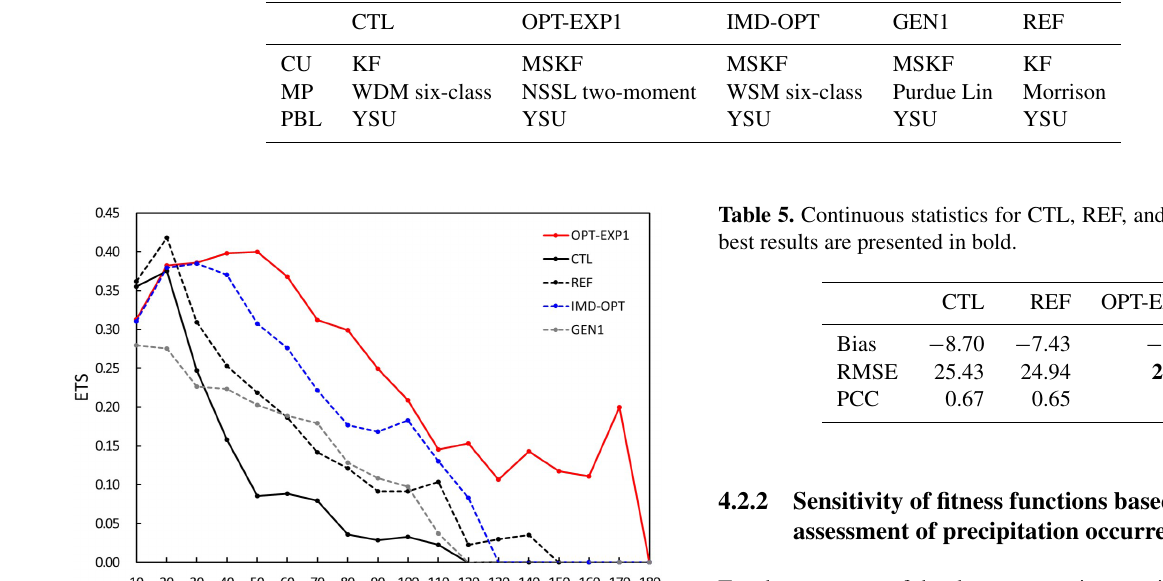
Table 4. The summary of selected schemes for CTL, OPT-EXP1, IMD-OPT, GEN1, and REF.